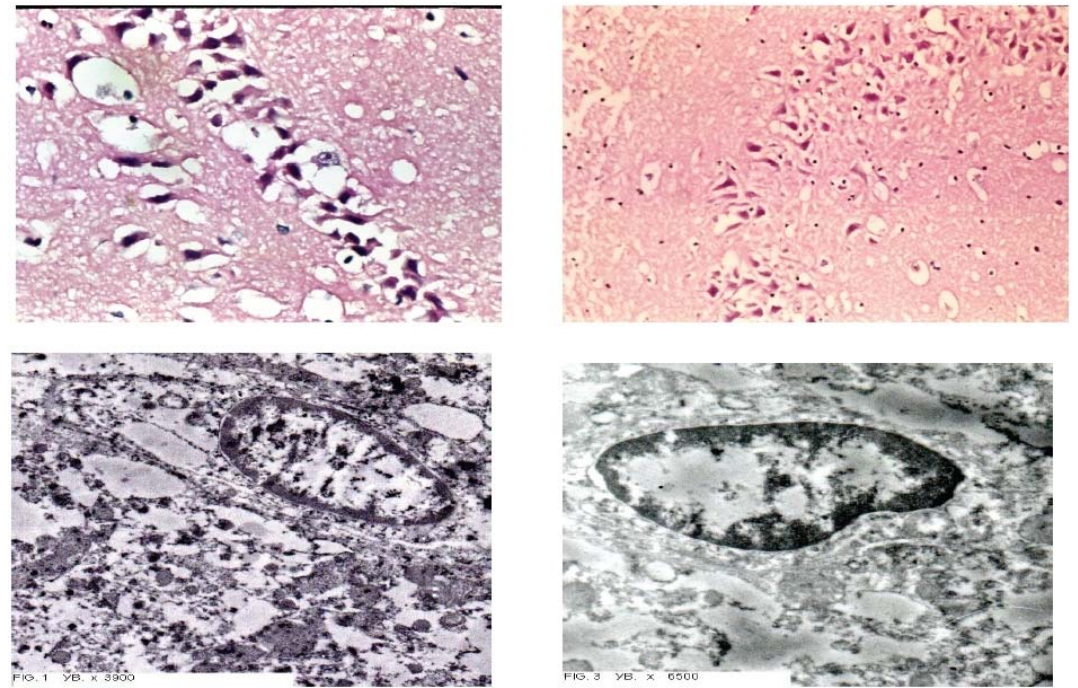
Fig. 6 Morphological changes in the CA1 zone of the hippocampus in rats with the model of hypoxia (left panels) and rats with hypoxia treated with metrifonate (right panels). Upper panels are data observed under light microscopy; lower panels are data observed under electronic